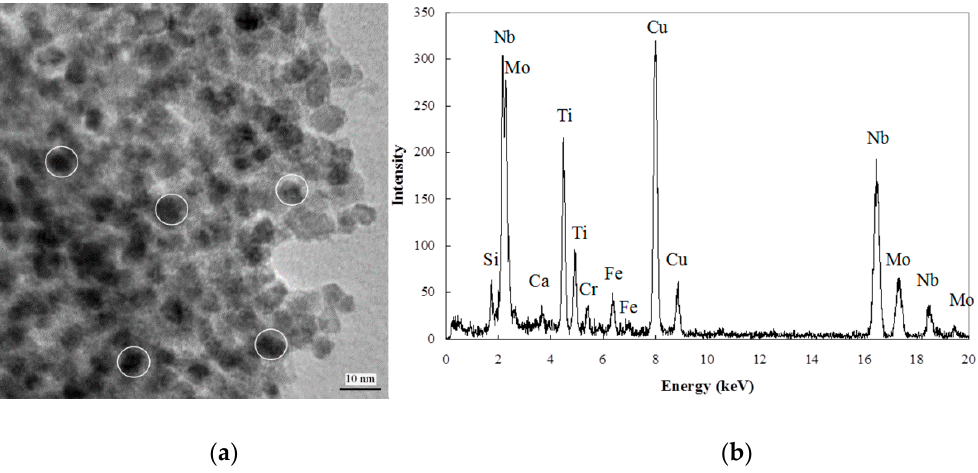
Figure 4. ( a ) TEM BF image of extracted nano-size precipitates and ( b ) EDX spectrum from a single circled region. Note that the Cu peaks are from the support grid, trace amounts of Cr from the Grade 100 composition, while Ca and Si are from inclusions also generated during the extraction process.